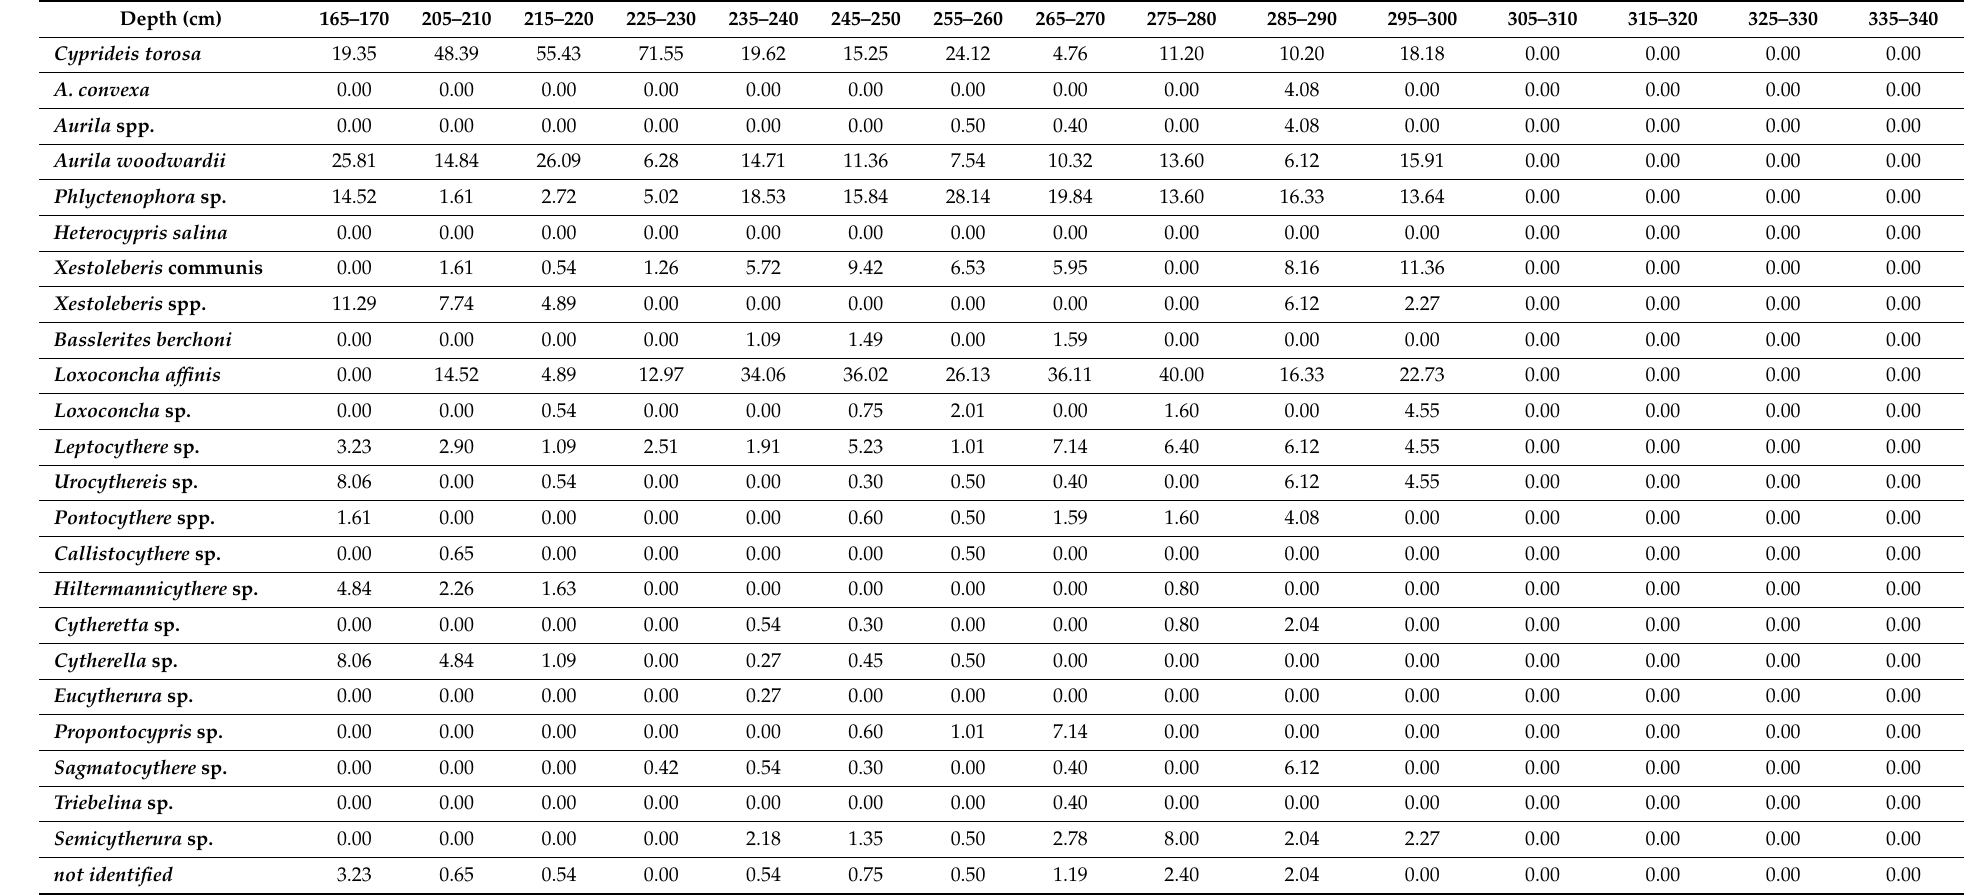
Table A8. Relative frequencies of the ostracod species in the studied samples of AKC3 (165–340